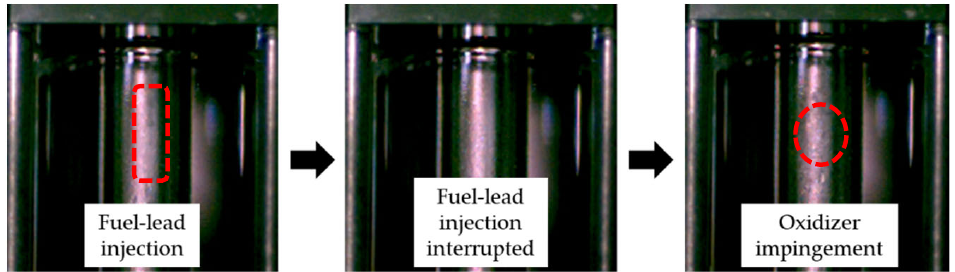
Figure 17. Interrupted fuel ‐ lead injection in hard start.